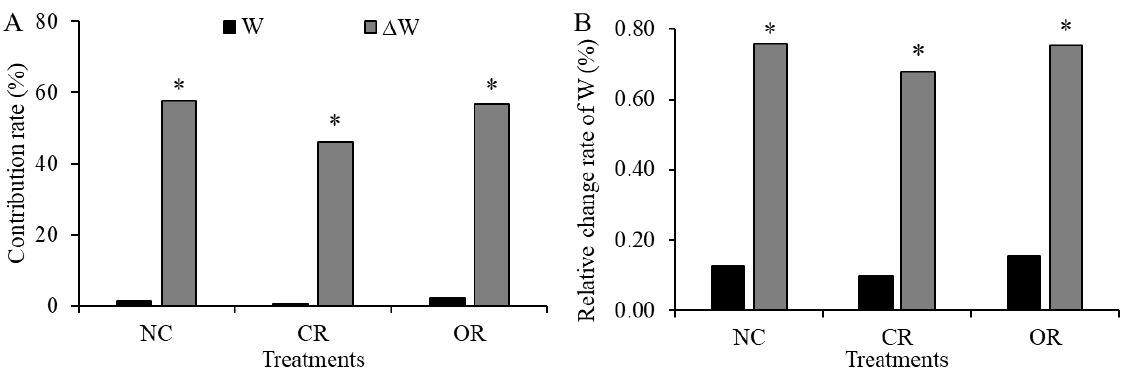
Figure 4. The contribution rate of precipitation to the W and ∆ W variation ( A ) and their relative change rates ( B ) at the daily scale. * indicates the significance at the p < 0.05 level. W : soil water storage, ∆ W : the change in soil water storage, NC: natural condition, CR: canopy + roots, OR: only roots.